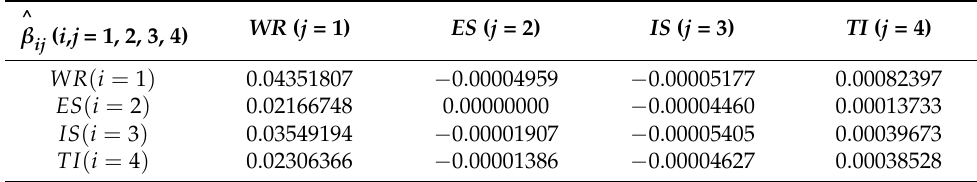
Table 4. Related parameters of GLV model in Tianjin